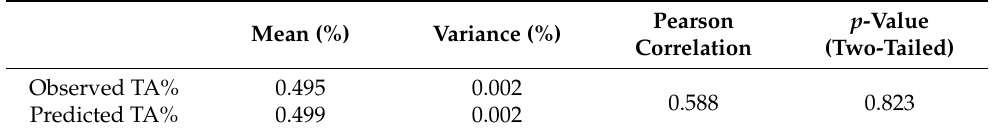
Table 7. Result of t test: paired sample test for observed and predicted TA% in mangosteen purée. Mean (%) Variance (%) Pearson Correlation p ‐ Value (Two ‐ Tailed) Observed TA%